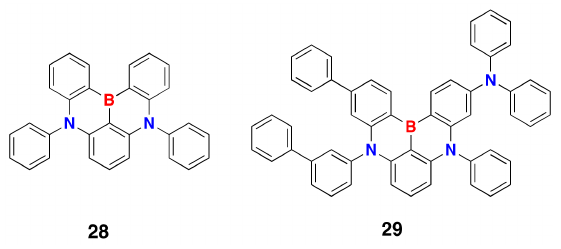
Figure 6. Boron-containing TADF emitters ( 28 – 29